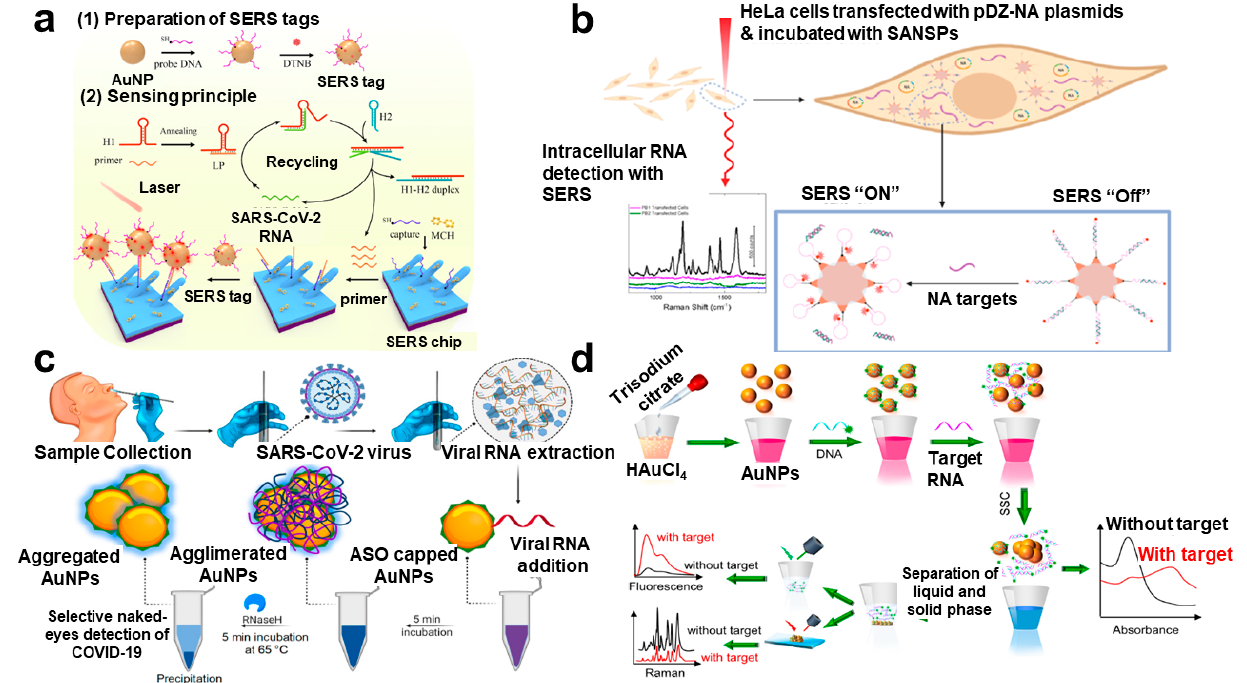
Figure 4. Viral RNA-target Raman and SERS-based biosensors using plasmonic nanomaterials: ( a ) Schematics of the point-of-care SERS biosensor using non-enzymatic signal amplification method. This figure is reproduced from [78] (© 2022 Elsevier B.V.); ( b ) Capture DNA-functionalized Au nanostar for the detection of intracellular viral mutation. This figure is reproduced from [79] (© 2022 American Chemical Society); ( c ) Plasmonic AuNPs-assisted colorimetric biosensor for detection of SARS-CoV-2 N gene RNA. This figure is reproduced from [81] (© 2022 American Chemical Society); ( d ) Colorimetric/SERS/fluorescence triple-mode plasmonic biosensor based on DNA-functionalized AuNPs. This figure is reproduced from [83] (© 2022 Elsevier B.V.).